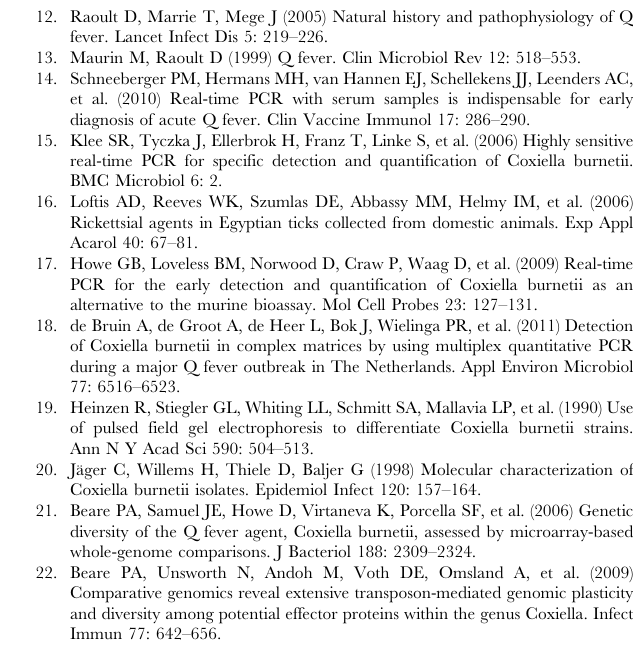
Figure S2 Ancestral and derived control vector insertion sequences. Primer binding sites are marked with boxes. CanSNPs are shown in boldface. Marker control sequences are placed in the following order: C.9, C.10, C.11, C.6, C.1, C.4, C.7,